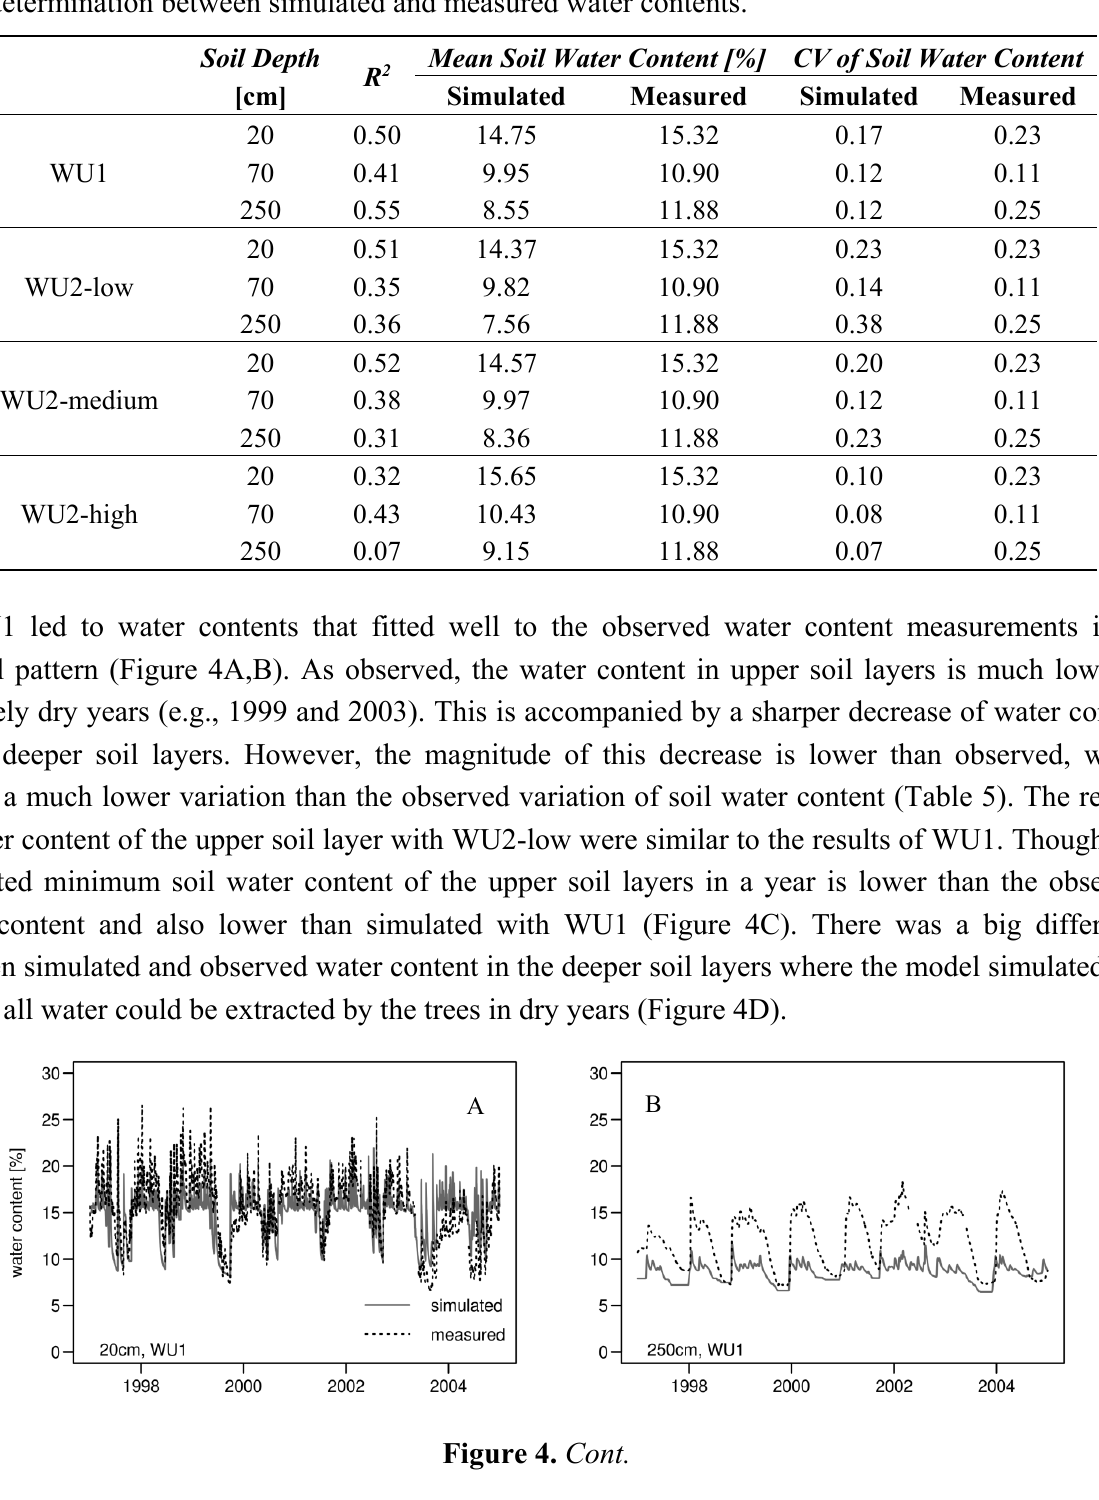
Table 5. Statistical analyses between mean simulated and observed volumetric soil water content from 1997–2004 at P1. CV is the coefficient of variation. R 2 is the coefficient of determination between simulated and measured water